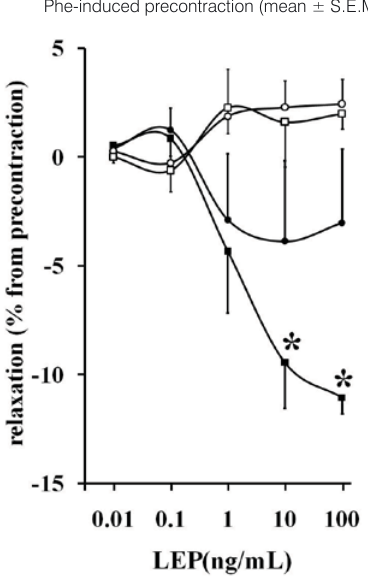
Figure 5. Vascular response of pulmonary artery rings from rats with pulmonary hypertension, precontracted with phenylephrine to increasing doses of leptin (LEP), either alone (squares) or after preincubation with apelin (circles). The vehicle effects alone or in the presence of apelin are presented as empty squares and circles. *P<0.05 as compared with vehicle alone (n=6). The LEP or vehicle effects are expressed as a percentage of Phe-induced precontraction (mean ±